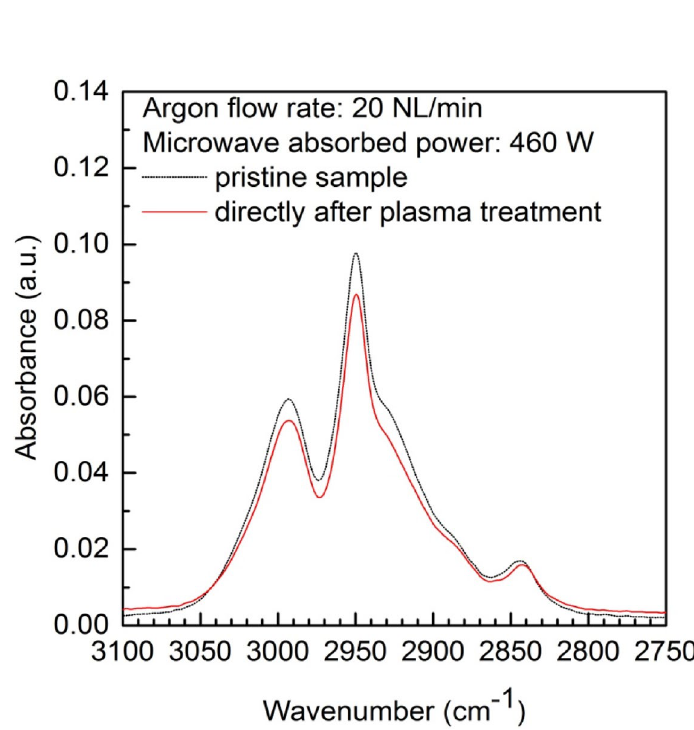
Figure 11. ATR FTIR spectra of PMMA polymer before and after plasma treatment in the wavenumber range of 3000–2750 cm −1 . Argon flow rate 20 NL/min. Microwave power 460